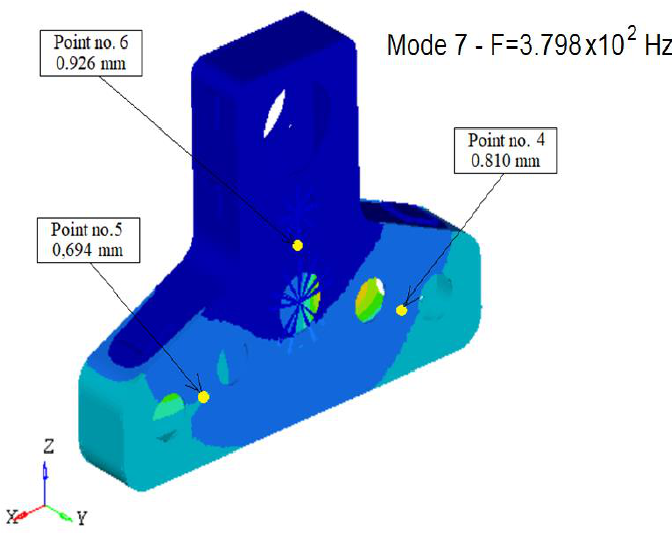
Figure 13. Displacements at the points on the rear surface of the housing for mode 7.